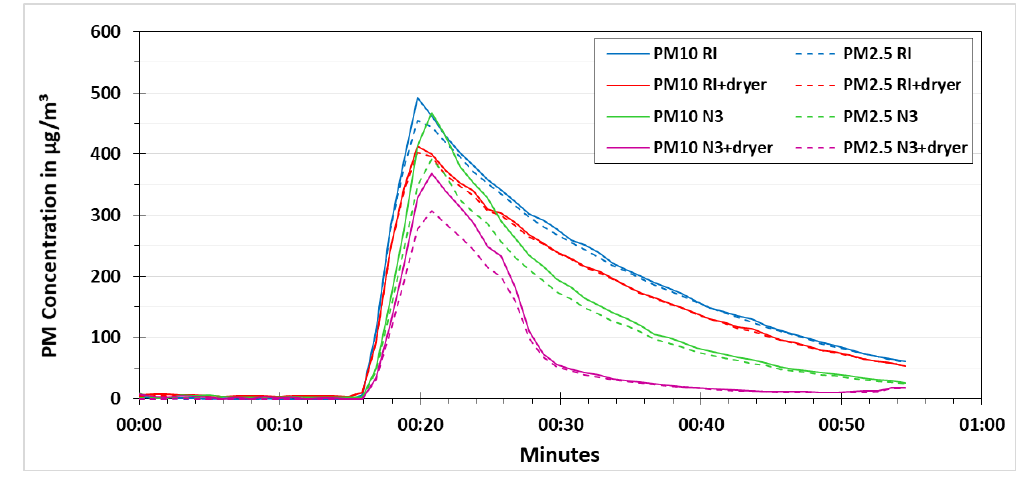
Figure 11. PM concentration comparison for testing the low-cost dryer at an applied voltage of 8 V.